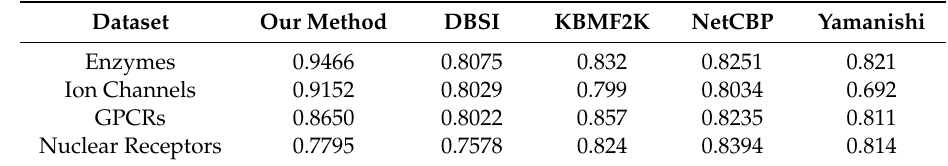
Table 6. The comparison of the area under the curve (AUC) values obtained between the proposed method and other existing methods on the gold standard